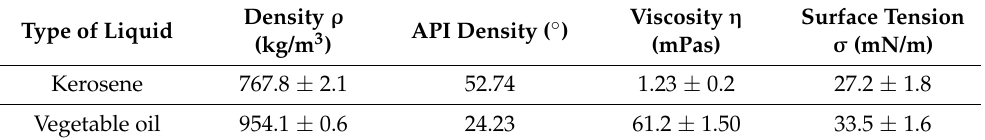
Table 1. Properties of basic liquids (T = 23 ◦ C).